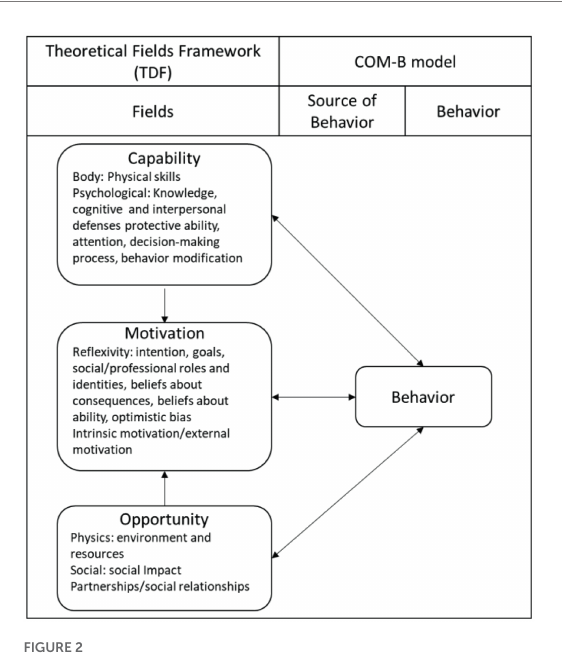
FIGURE 2 COM-B theoretical fields and